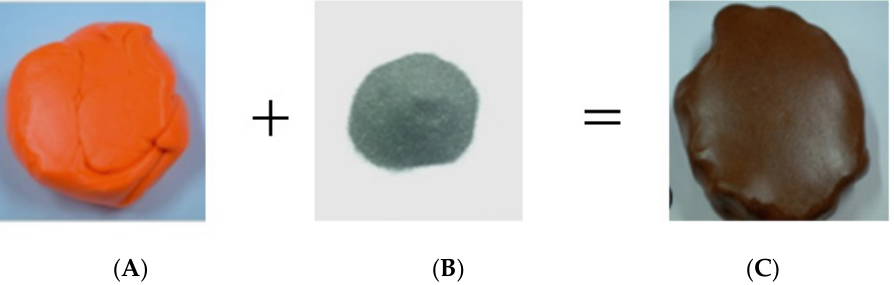
Figure 5. Diagrams of making the gel abrasive before RDSM-AFM: ( A ) Silicone gel; ( B ) silicone carbon; ( C ) gel abrasive.